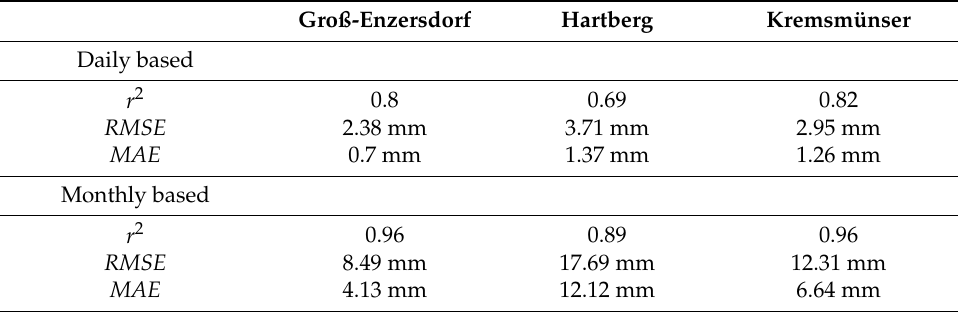
Table 3. Statistical parameters of rainfall differences between point-measured (ZAMG) (as reference) and INCA 1km for the months March until July